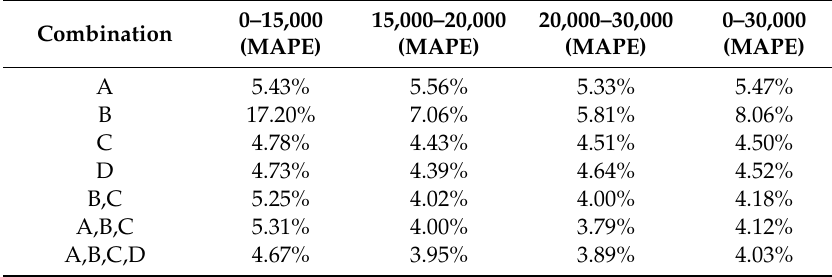
Table 8. MAPE for each section of Ec predicted using the ensemble method.